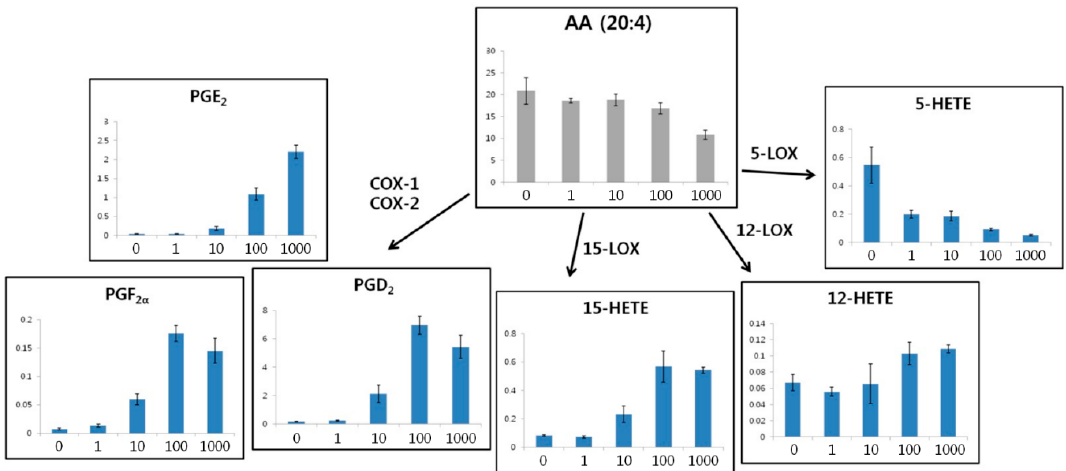
Figure 7. The eicosanoid synthesis pathway from arachidonic acid (AA) and eicosanoid levels in RAW264.7 cells as a function of LPS concentration (0, 1, 10, 100, and 1000 ng/mL). COX, cyclooxygenase; LOX, lipoxygenase; PG, prostaglandin; HETE, hydroxyeicosatetraenoic acid.